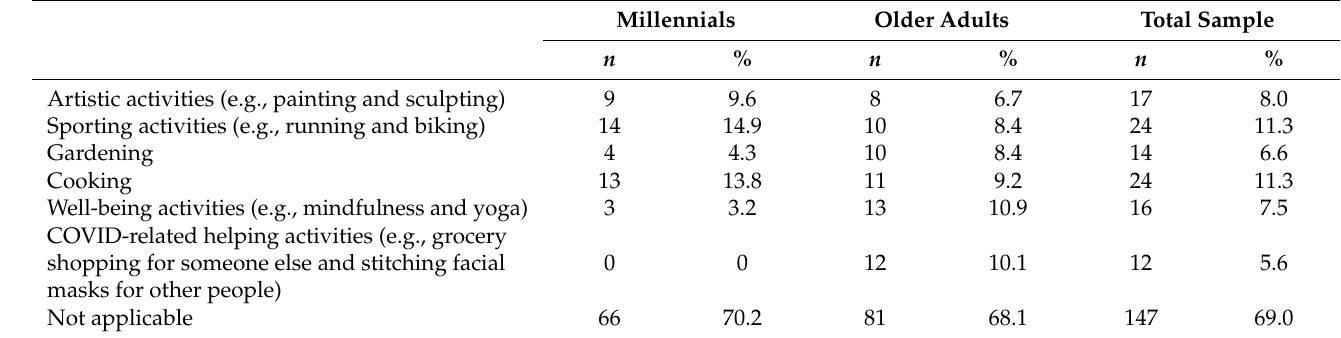
Table 3. Contingency table representing activities depending on generation’s belonging.